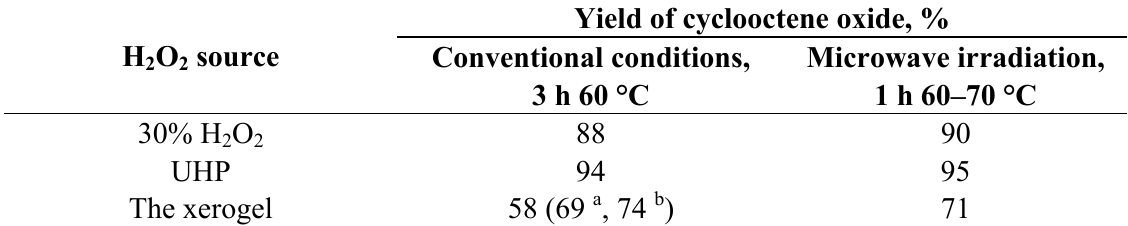
Table 3. Effect of the source of H and microwaves